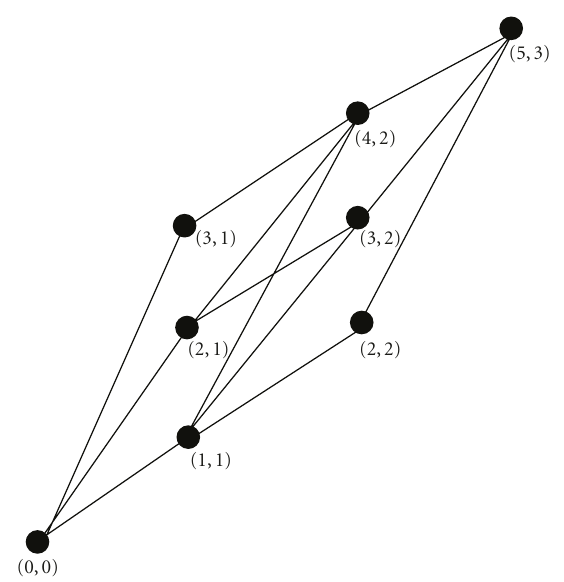
Figure 3: The network constructed for M = 5 users, and K = 3 sectors.